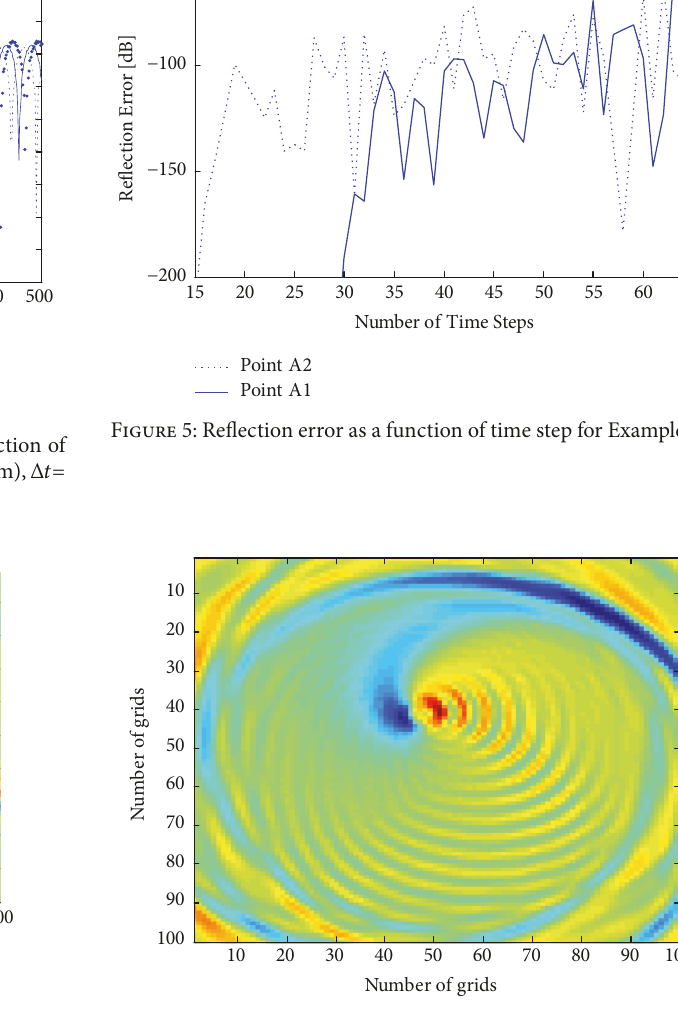
Figure 6: √𝜇𝐻 𝑛 𝑧 at time step n=20 for Example III. 𝑖,𝑗